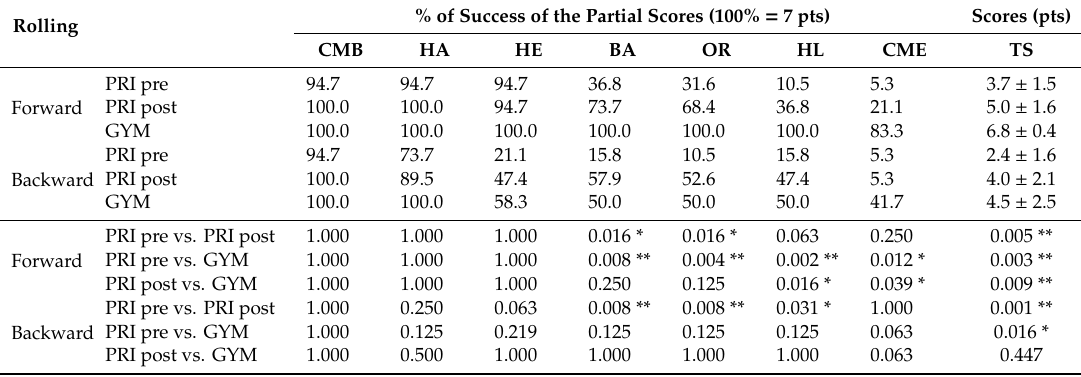
Table 3. Comparisons between pre- and post-training and between PRI (primary school children) and GYM